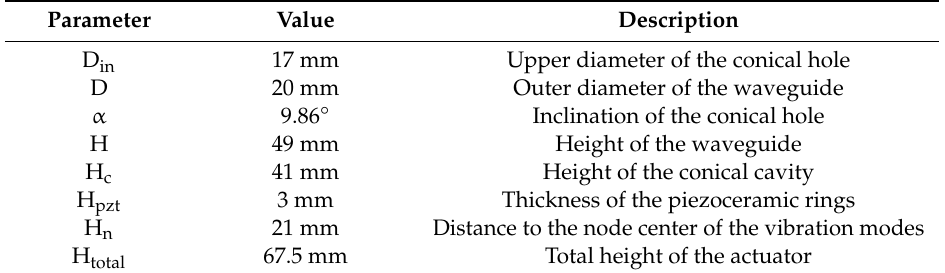
Table 1. Dimensions of the